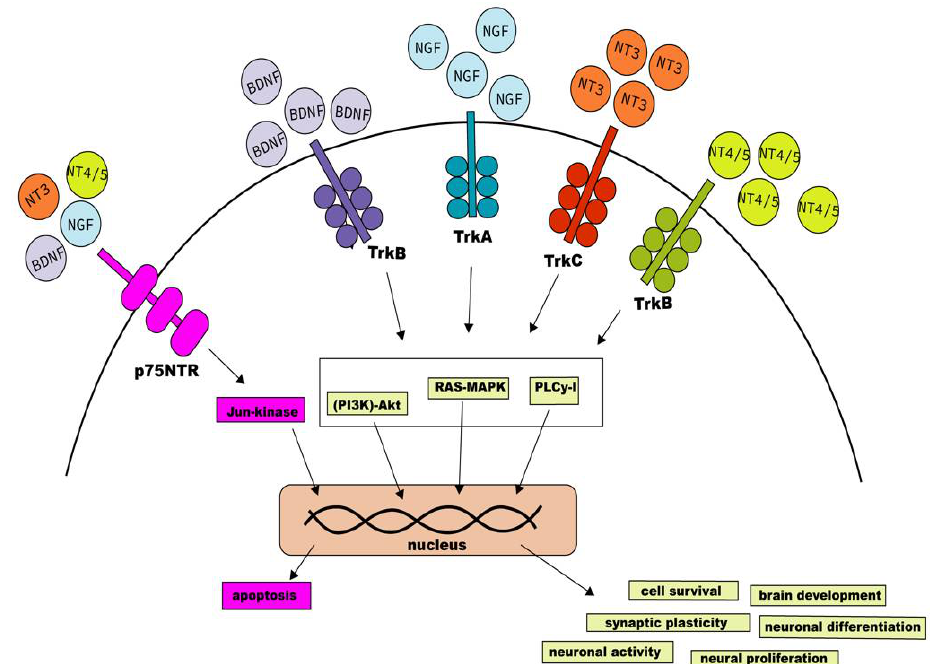
Figure 1. Neurotrophin signaling pathways. The figure shows different NTs (NGF, BDNF, NT3, and NT4/5) in a distinctive color with their high-affinity receptors (TrkA, TrkB, and TrkC) and the p75NTR, which can bind to all the NTs mentioned above. The figure also shows the main intracellular signaling pathways and the different effects on the cell